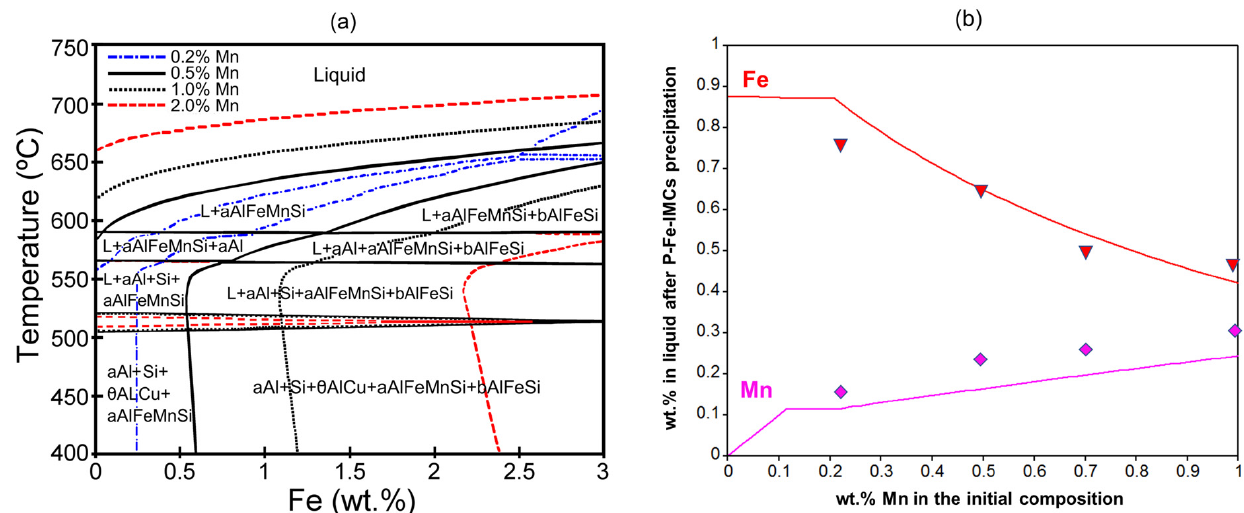
Figure 4. ( a ) Equilibrium phase diagram of the A380 alloy versus Fe for different Mn additions. Reprinted with permission from ref. [44]. Copyright 2022 Elsevier; ( b ) Fe and Mn in liquid A380-1Fe alloy versus Mn content when held at 610 °C. Lines are predictions from Pandat software and the points are experimental values obtained at 605 ± 5 °C.